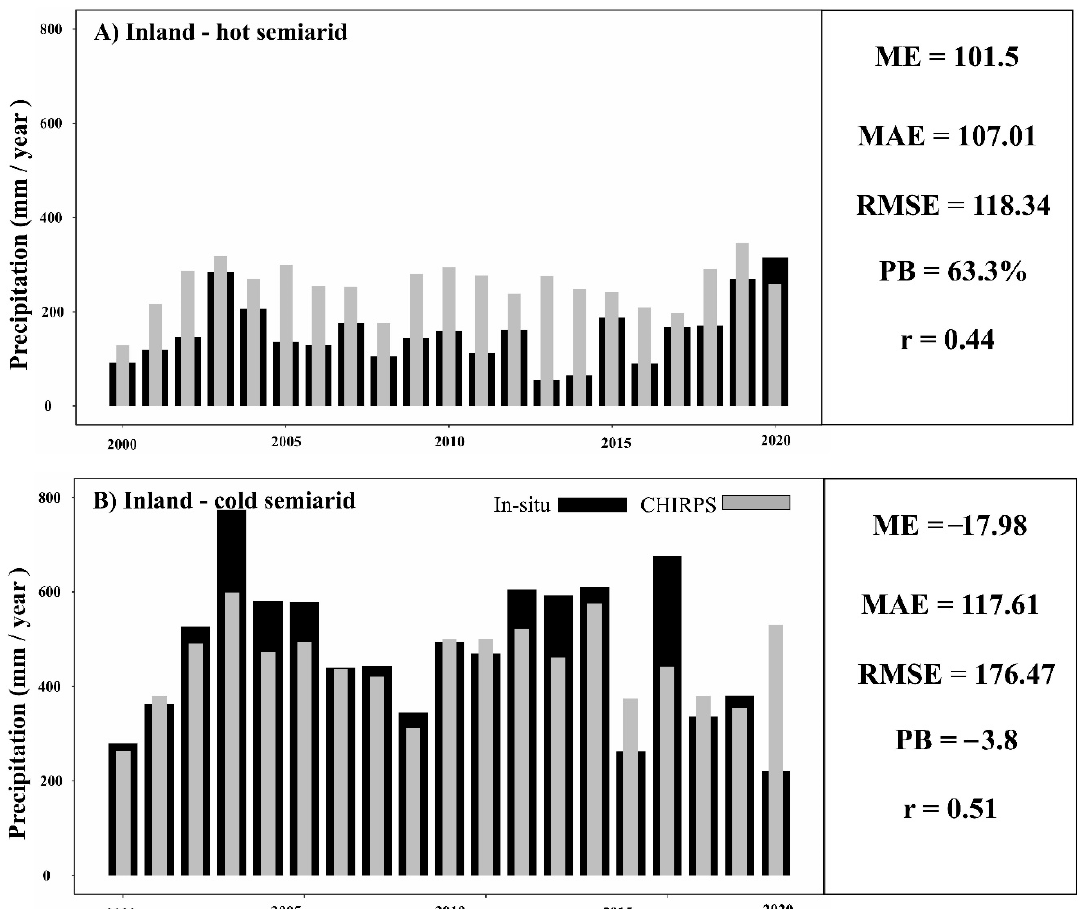
Figure 9. Composite plot of annual time series with corresponding accuracy statistics. ( A ) Inland, B ) Highland.